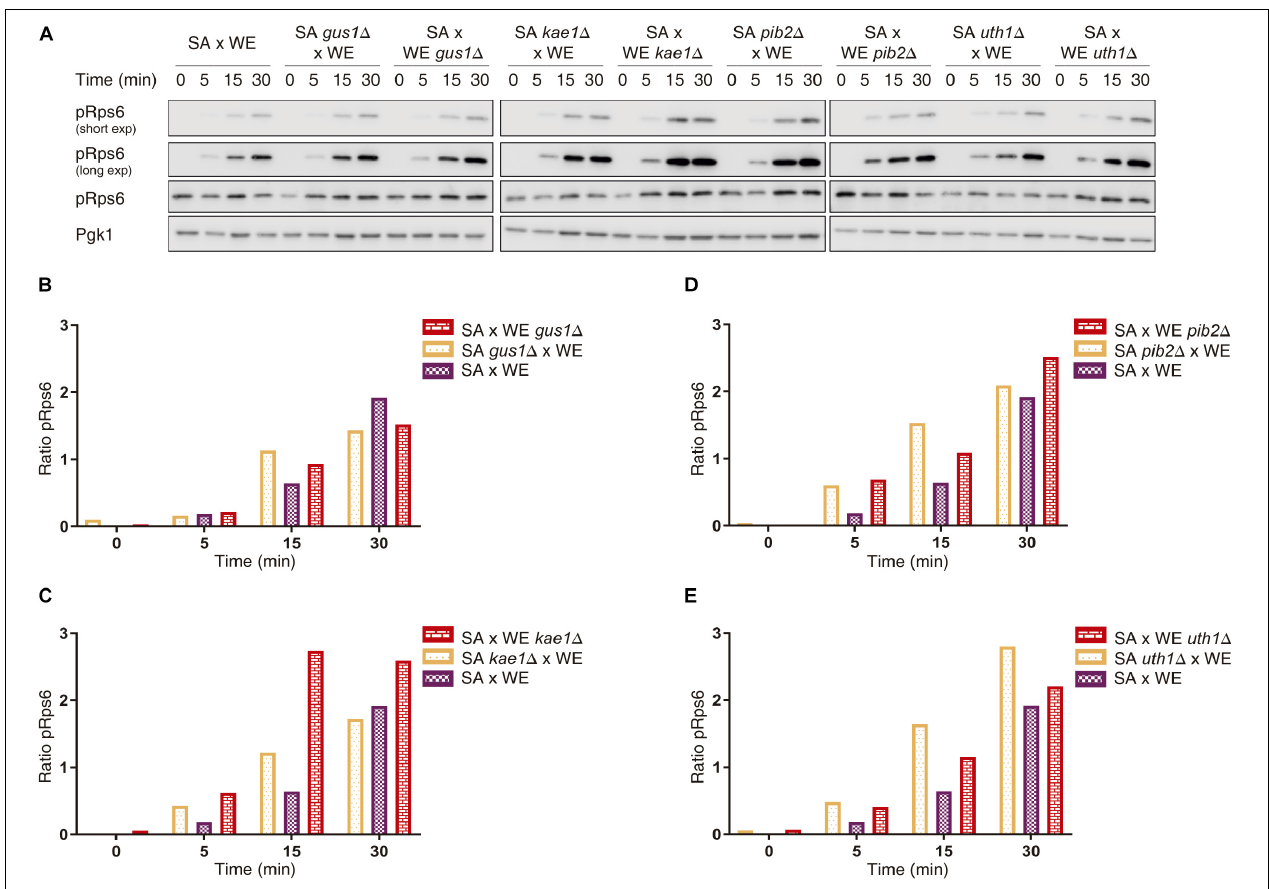
FIGURE 3 | Quantification of Rps6 phosphorylation for reciprocal hemizygous strains. (A) Western blot for the reciprocal hemizygous strains. Phosphorylated (pRps6) and total Rps6 protein levels were evaluated using specific antibodies. Time 0 min corresponds to the addition of glutamine. Pgk1 was used as a loading control. (B–E) Quantification of Rps6 phosphorylation for the genes GUS1 (B) , KAE1 (C) , PIB2 (D), and UTH1 (E) . The “Ratio pRps6” is the ratio between pRps6 band intensity and the total Rps6 band intensity, normalised by the mean value of all the ratios